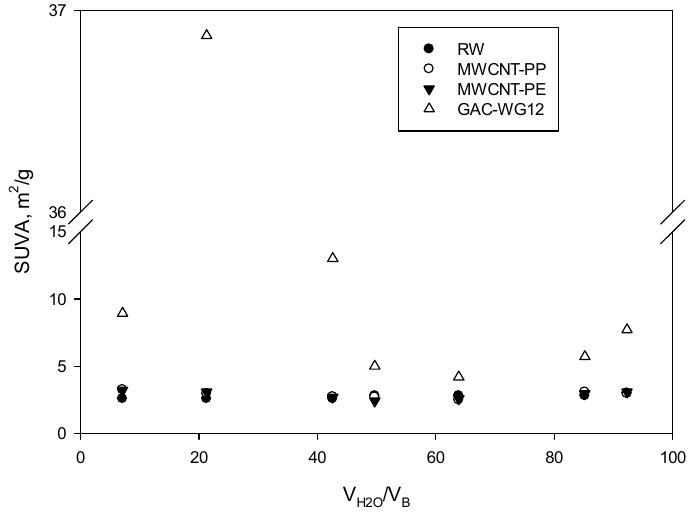
Figure 9. The specific UV absorbance values in raw and filtered water.